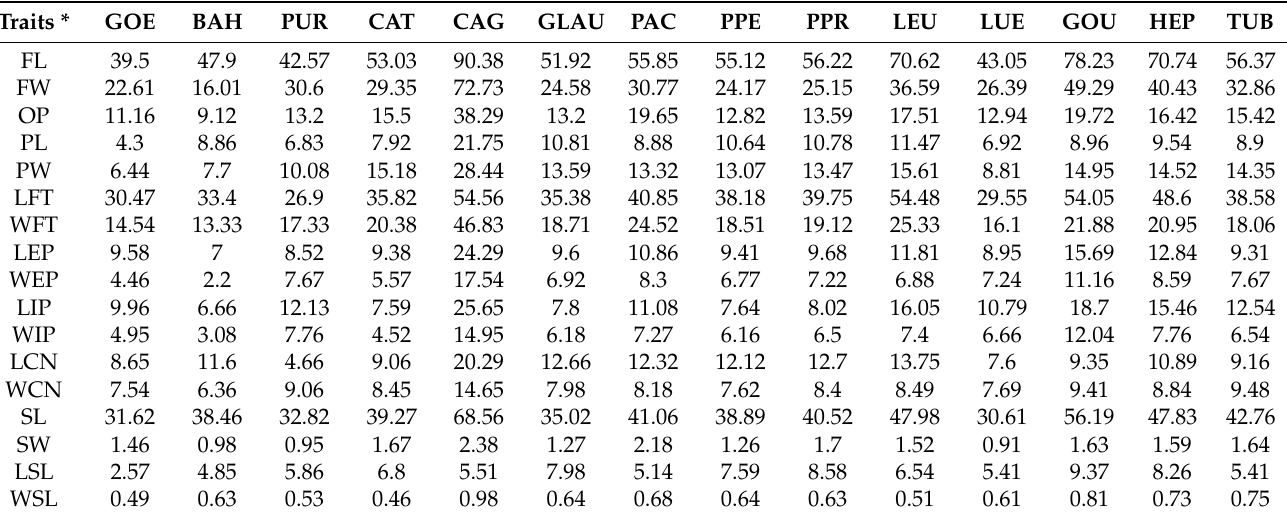
Table A1. Mean values of the measured (mm) characteristics of the flowers of the species of